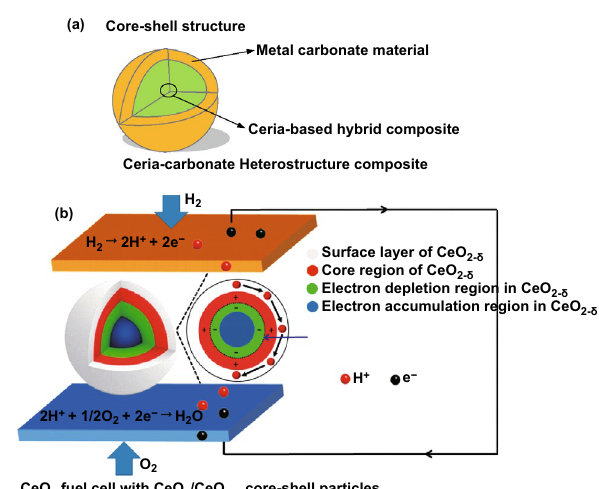
Fig. 2 Illustration of core–shell structure of ceria‑based heterostruc‑ ture composite (CHC) systems: a ceria–carbonate CHC and b CeO 2 core–shell particles as an electrolyte in CeO 2 / CeO 2−δ core–shell structure. Reproduced with permission from Ref. [23].